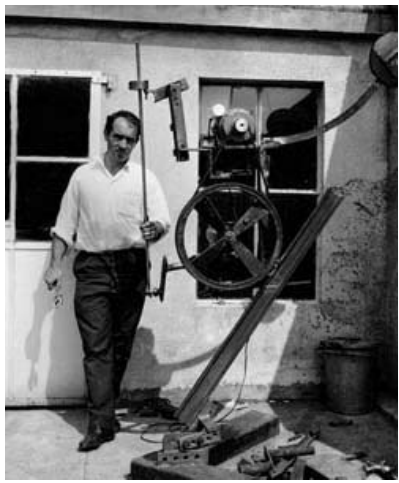
Figure 2. Jean Tinguely with an early example of his “Eos“ series. Photograph licensed under Creative Commons © ErlingMandelmann.ch.